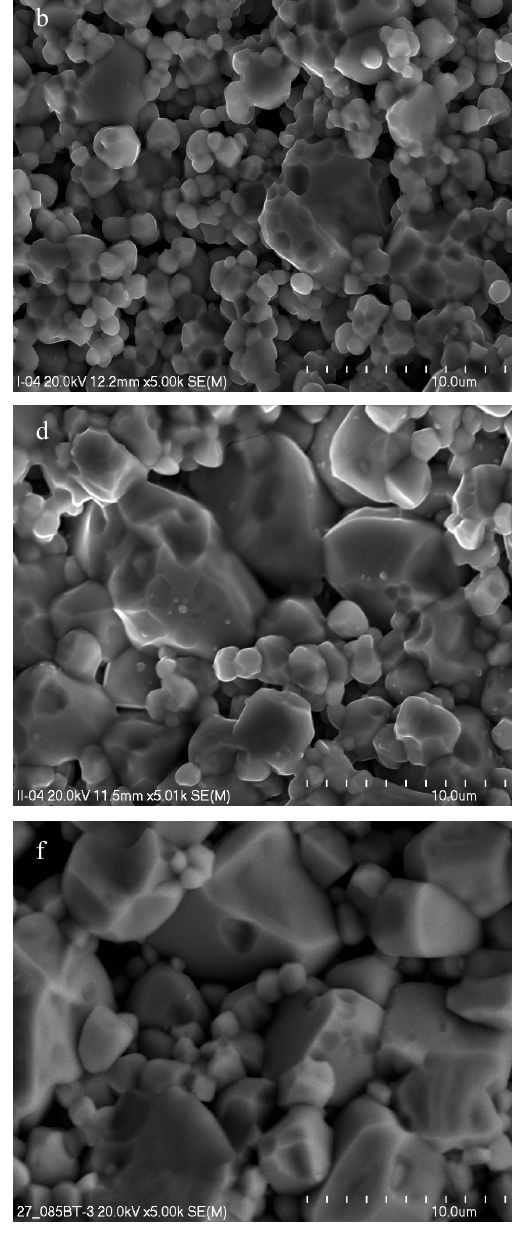
Fig. 1 SEM micrographs of fracture surface of (1  x )BT– x PMN ceramics: (a) x = 0, (b) x = 0.025, (c) x = 0.05, (d) x = 0.075, (e) x = 0.1, and (f) x =